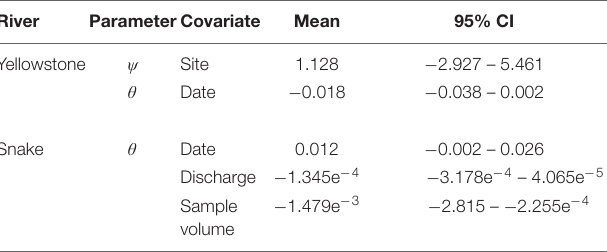
TABLE 4 | Estimates of the regression coefficients from the top models. River